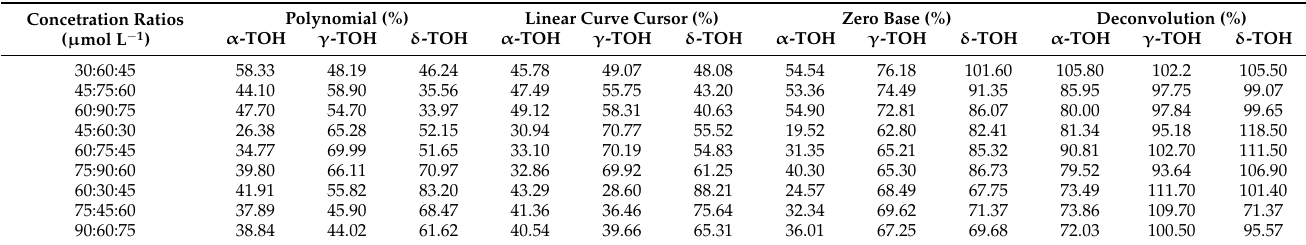
Table 3. Comparison evaluation methods in determination of accuracy presented as recovery values. Concetration Ratios ( µ mol L − 1